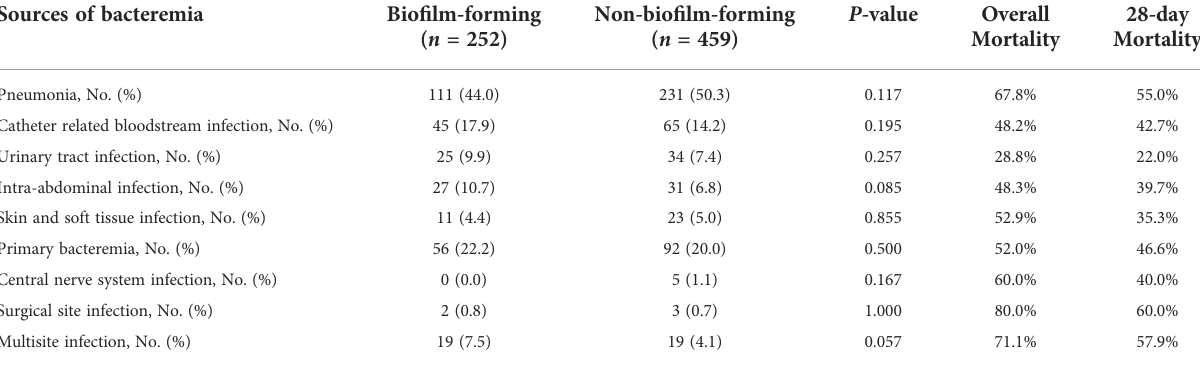
TABLE 5 Types of infections caused by bio fi lm-forming and non-bio fi lm-forming isolates of Acinetobacter baumannii . Sources of bacteremia Bio fi